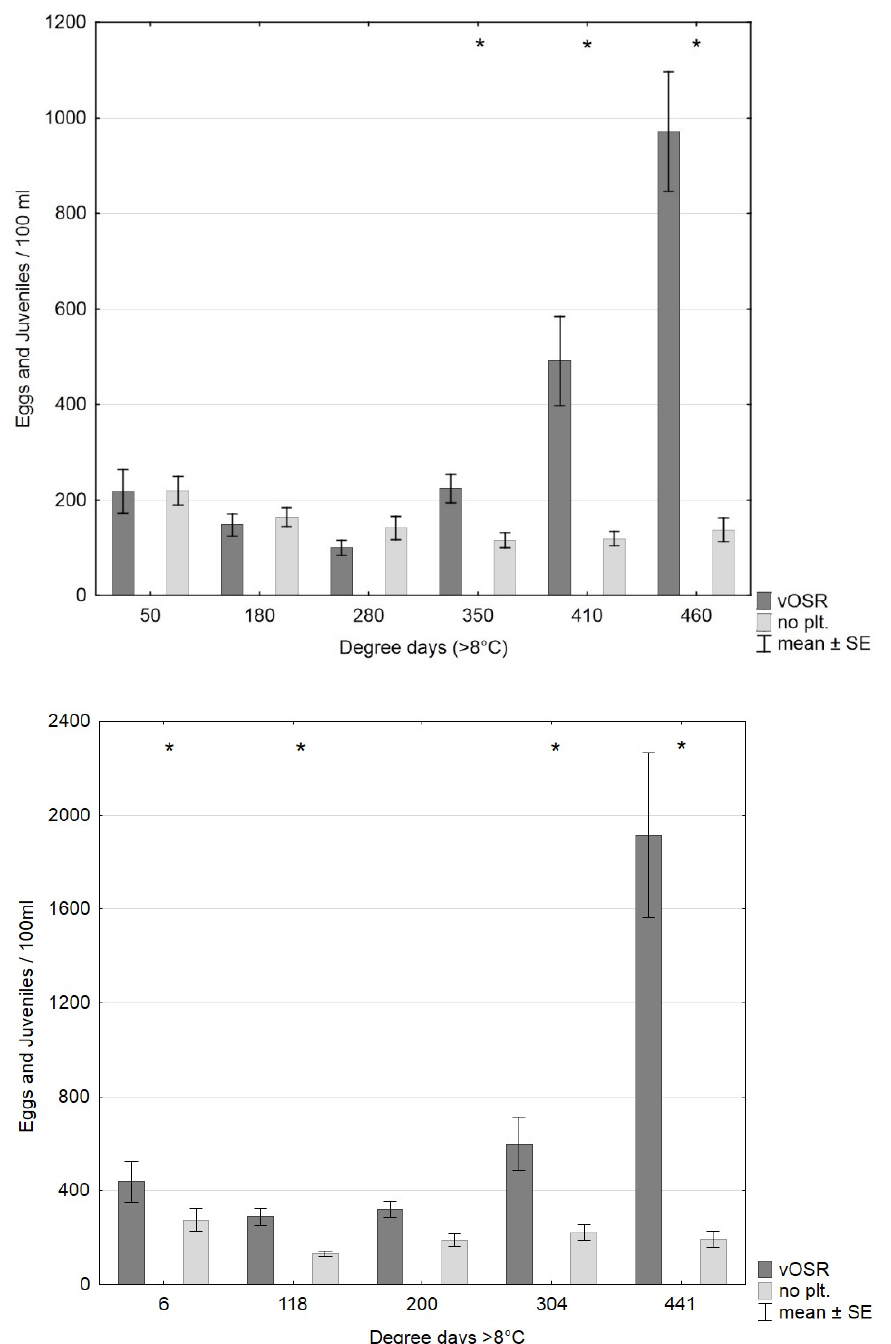
Figure 5. Population dynamics of beet cyst nematodes (BCN) during 460 (in 2016, below ) and 441 (in 2011, above ) degree days (>8 °C) post winter oilseed rape cultivation under uncontrolled growth of volunteer oilseed rape (vOSR) and without plant coverage; * Differences between treatments within degree days are significant if indicated using t -Test ( p < 0.05).